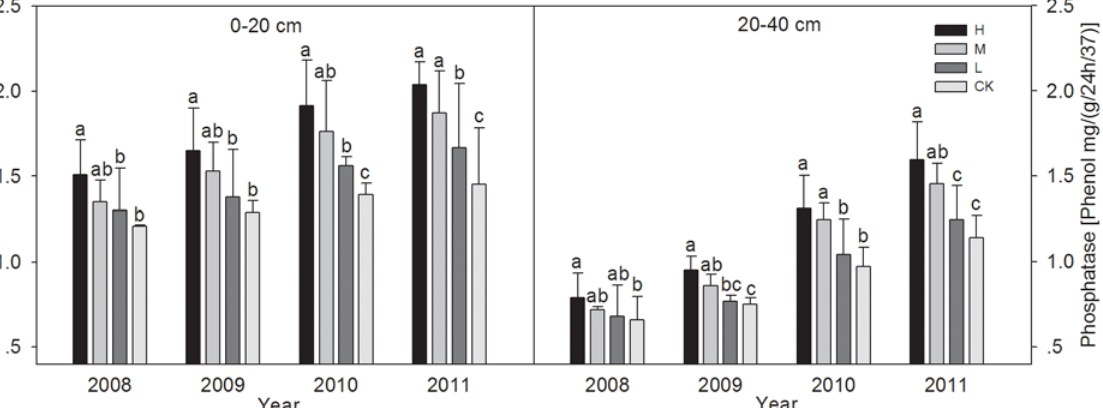
Fig 3. The changes of Phosphatase activities in 0 – 20 and 20 – 40 cm soil layers under different wheat straw incorporation treatments. Note: CK, no straw incorporation; L, incorporation of straw at a low rate of 3 000 kg hm -2 wheat straw; M, incorporation of straw at a medium rate of 6 000 kg hm -2 wheat straw; H, incorporation of straw at a high rate of 9 000 kg hm -2 wheat straw. Bars with different lowercase letters indicate significant differences ( P < 0.05).